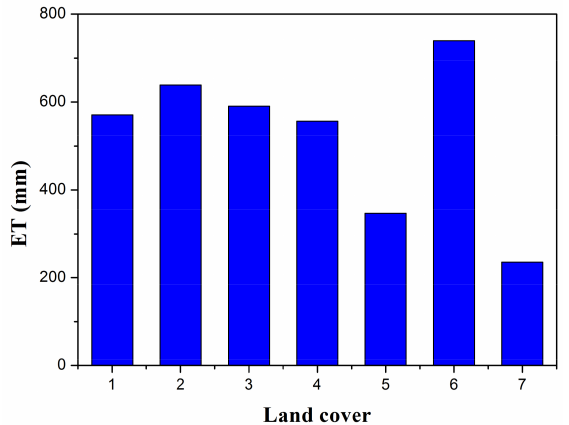
Figure 8. Variation in the annual ET for different land covers over the whole basin from the enhanced method (1: Dry farmland, 2: Paddy field, 3: Arbour forest, 4: Shrub forest, 5: Grassland, 6: Water surface, 7: Artificial